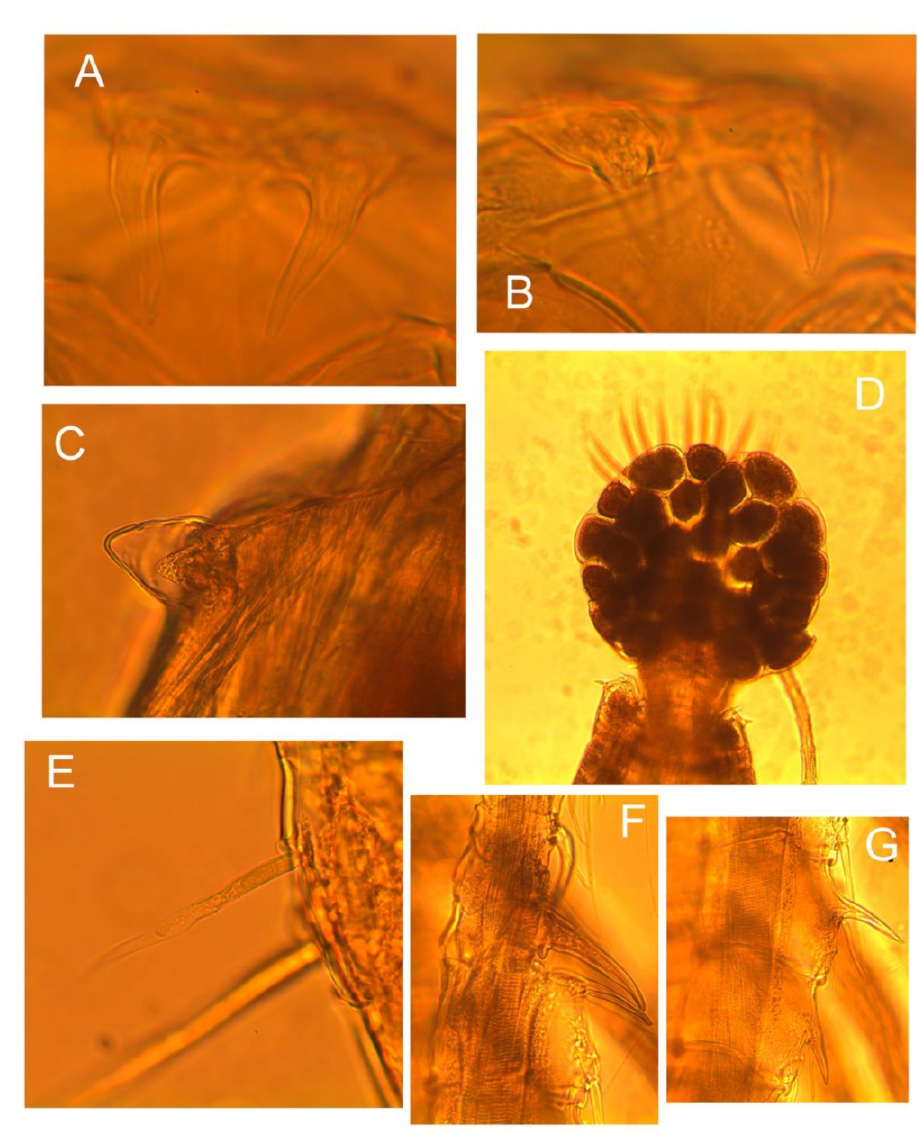
Figure 3. Mastigodiaptomus ha , adult female from 25 Horas Lagoon (island population): ( A ) large curved rostral spines; M. ha , adult female from Verde Lucero Lagoon (continental population): ( B ) short acute rostral spines; M. ha , adult female from 25 Horas Lagoon: ( C ) dorsal process, lateral view; ( D ) egg sac, dorsal view; ( E ) modified setae on antennulary segment 11. M. ha , adult male from 25 Horas Lagoon: ( F ) right antennule segments 13, 14; ( G ) same, segments 15,